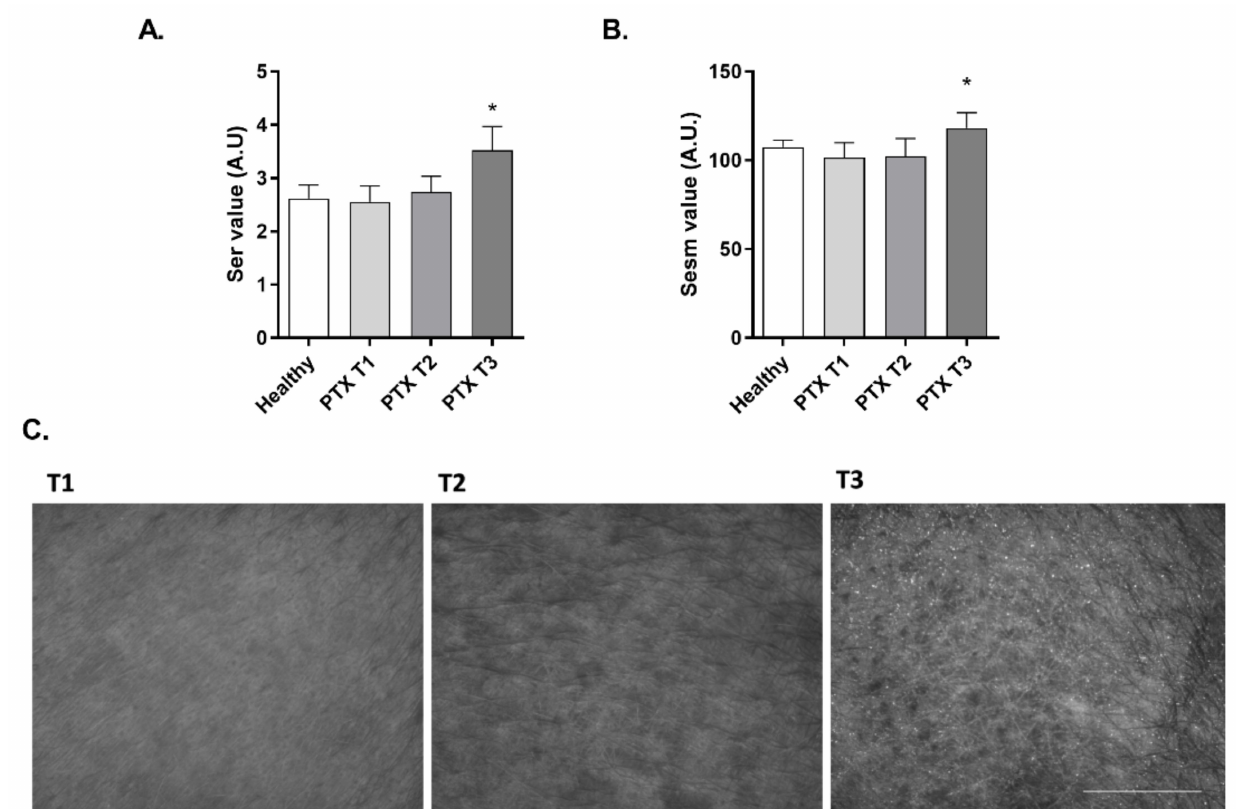
Figure 4. Paclitaxel induces an increase of skin roughness and reduces its smoothness in cancer patients. ( A , B ) Skin roughness and smoothness were measured in 20 oncologic patients before (T1), during (T2), and after (T3) treatment with paclitaxel (PTX), and in 20 healthy subjects as a control group. Measurements were conducted in the cheekbone by Visioscan ® VC 98 probe, obtaining the Ser and Sesm values calculated by the software from each grayscale photograph. Results are expressed as the mean ± standard deviation of at least 3 measurements each time ( n = 20); * p < 0.05 vs. T1. ( C ) Representative images of the skin topography obtained with Visioscan ® during PTX treatment at time points T1, T2, and T3. White and bright gray on the images are associated with a bad condition of the skin. Scale bar 1